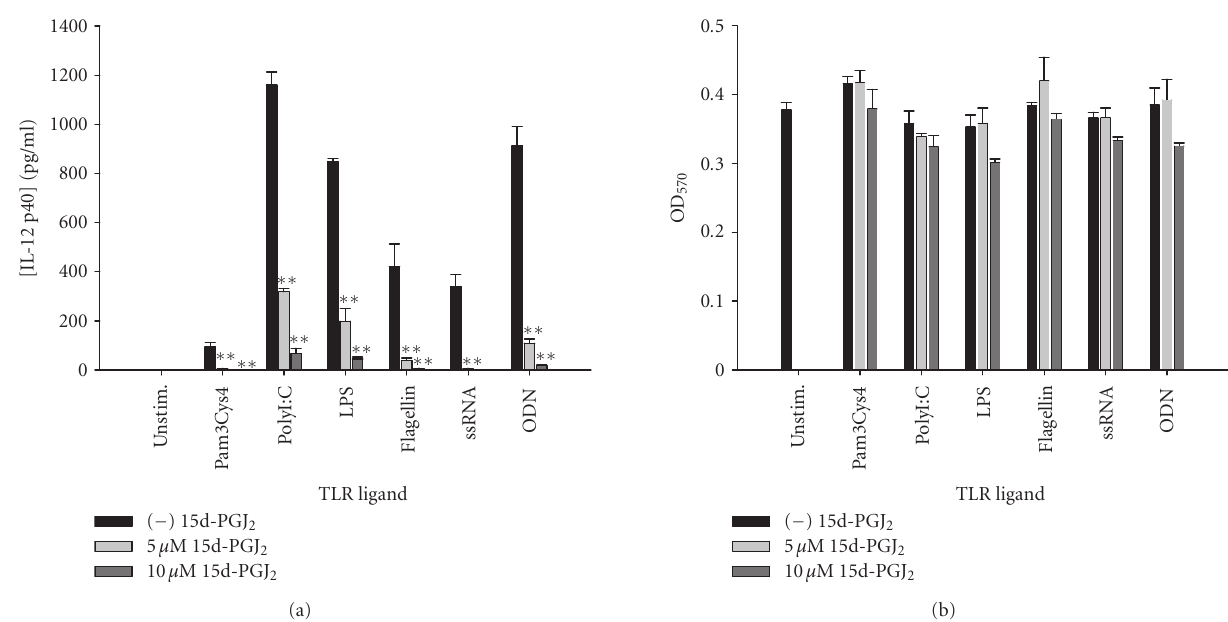
Figure 1: The natural PPAR- γ agonist 15d-PGJ 2 is a potent inhibitor of microglial IL-12 p40 production in response to a vast array of TLR ligands. Primary microglia were plated at 2 × 10 5 cells/well in 96-well plates and incubated overnight. The following day, cells were pretreated for 1 hour with the indicated concentrations of 15d-PGJ 2 prior to the addition of TLR ligands. Cell-conditioned supernatants were collected at 24 hours following TLR ligand exposure, whereupon IL-12 p40 levels were determined by ELISA (a). The e ff ects of 15d-PGJ 2 on microglial viability were assessed using an MTT assay (b). Significant di ff erences between microglia treated with TLR ligands alone versus TLR ligands + 15d-PGJ 2 are noted with asterisks ( ∗∗ P < . 001). Results presented are representative of two independent experiments.